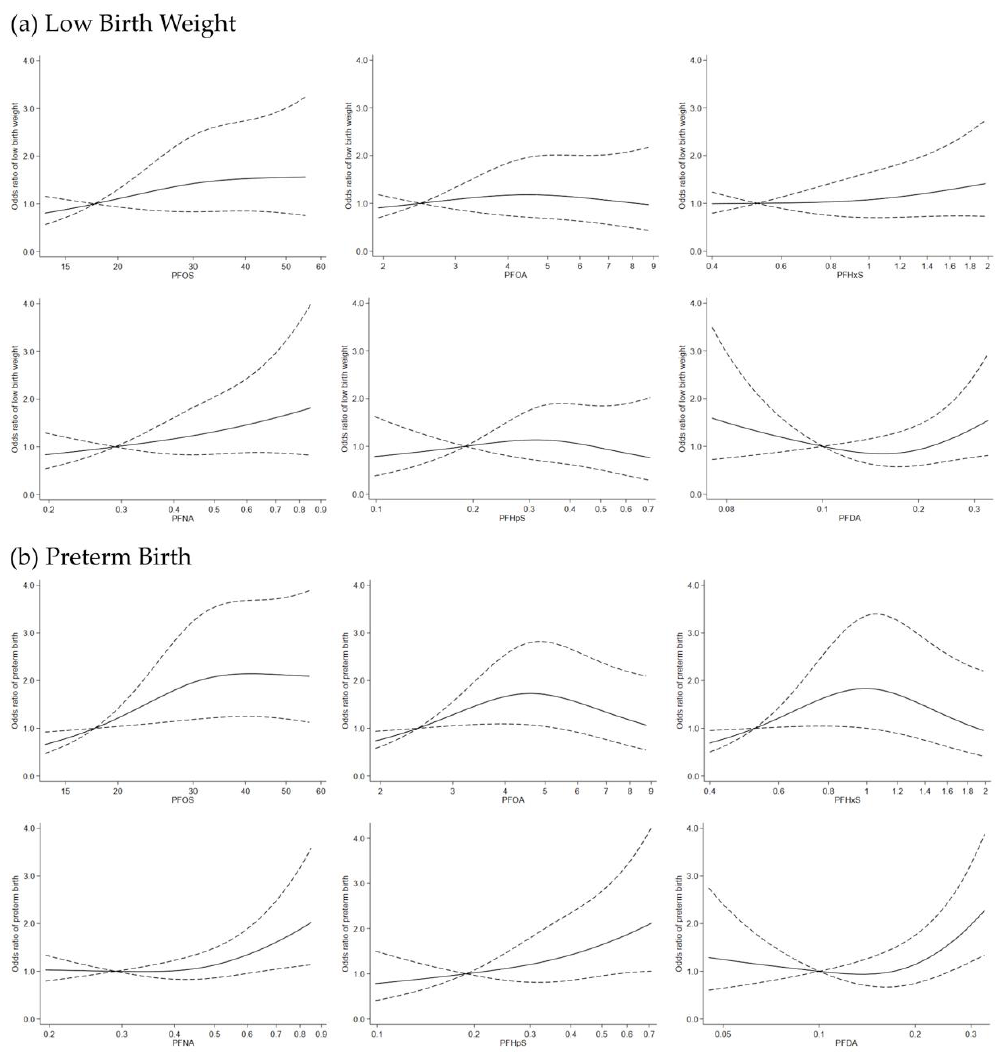
Figure 2. Odds ratio for low birth weight ( a ) and preterm birth ( b ) according to continuous PFASs values using a restricted cubic spline regression model with three knots at the 10th, 50th and 90th percentiles. The dashed lines represent 95% confidence intervals for the spline model (reference is the 10th percentile of each PFASs level). Model adjusted for a study sample indicator, infant sex, infant birth year, gestational week of blood draw, maternal age, parity, socio-occupational status, pre-pregnancy body mass index (BMI), smoking and alcohol intake during pregnancy. In graph ( a ), the p -values for non-linearity for PFOS, PFOA, PFHxS, PFNA, PFHpS and PFDA and low birth weight were 0.52, 0.43, 0.55, 0.88, 0.35, and 0.05, respectively. In graph ( b ), the p -values for non-linearity for PFOS, PFOA, PFHxS, PFNA, PFHpS and PFDA and preterm birth were 0.10, 0.01, 0.01, 0.05, 0.69, and 0.01,